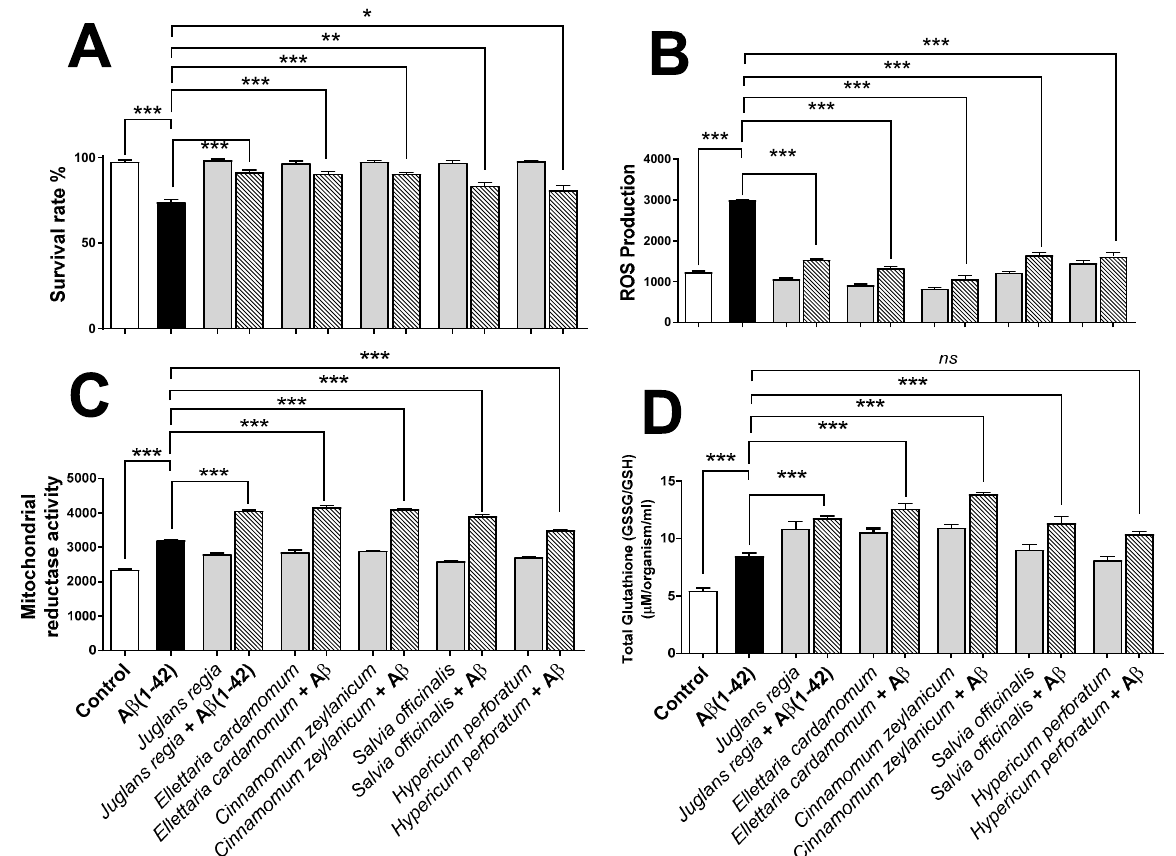
Figure 5. Evaluating the ability of plant extracts to ameliorate the effects of amyloid beta A β (1-42) in Globodera pallida. ( A ) Percentage survival of G. pallida was determined by visual counting of living/dead organisms following exposure to A β (1-42) alone, plant extracts, or plant extracts in combination with A β (1-42). ( B ) ROS production was monitored using the DCFH-DA assay, and the fluorescence (Ex: 495 nm/Em: 529 nm) was measured every 30 min for 24 h; the results are reported as areas under the curve (AUC). ( C ) For mitochondrial reductase activity, G. pallida were incubated with Alamar Blue, and the fluorescence (Ex: 530 nm/Em: 590 nm) was measured every 30 min for 24 h. The results are reported as AUC. ( D ) Total glutathione is the ratio of oxidized glutathione (GSSG) to reduced glutathione (GSH), which is a measure of cellular oxidative stress. It was determined by employing OxiSelect ™ Total Glutathione assay in the presence of nicotinamide adenine dinucleotide phosphate (NADPH) at 405 nm. The total glutathione content in unknown samples is determined by comparison with the predetermined glutathione standard curve. In each type of experiment, the nematodes were exposed to A β (1-42) alone (100 µM), plant extracts ( n = 5; 100 µg/mL), or plant extracts ( n = 5; 100 µg/mL) in combination with 100 µM A β (1-42). Control represents untreated cells (vehicle control); heat-killed G. pallida (not shown) were also performed as controls. Approximately 50 G. pallida J2 organisms per replicate were used in survival assays, ~100 organisms were used in mitochondrial reductase and ROS assays, and glutathione studies involved ~1000 organisms per replicate. Data are mean ± SEM ( n = 3), * p < 0.05, ** p < 0.01, *** p < 0.001 (significance), and ns (not significant) for the statistical comparisons indicated (one-way analysis of variance).